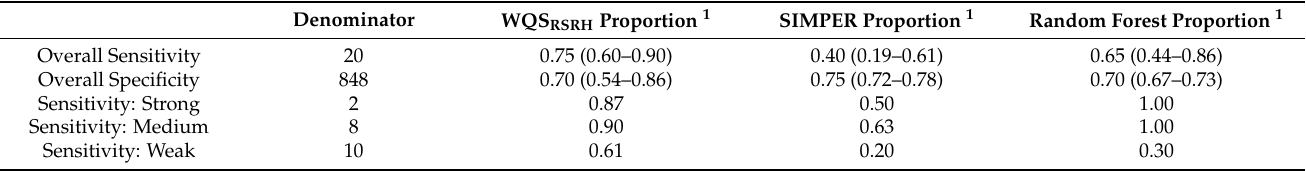
Table 2. Sensitivity and specificity in identifying the 20 associated operational taxonomic units (OTUs) for weighted quantile sum regression with random subsets and repeated holdouts (WQS RSRH ), similarity percentage (SIMPER), and Random Forest models. For WQS RSRH the sensitivity and specificity were averaged across 30 repeated holdout datasets with a cutoff of 0.00115 (=1/868). For SIMPER, one model was conducted with 999 permutations, and the cutoff of importance was 70% cumulative variance. For Random Forest, one model was conducted with 100 trees, and importance scores were converted to a proportion, with a cutoff of